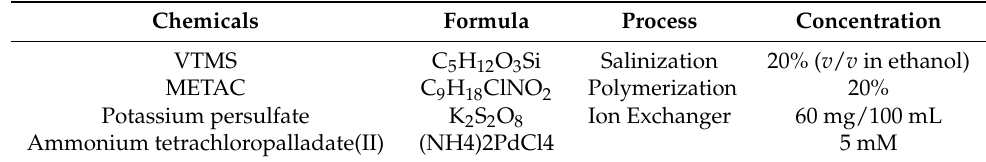
Table 2. Chemicals used for functionalization. VTMS, vinyl-tri-methoxy-silane; METAC, (2-